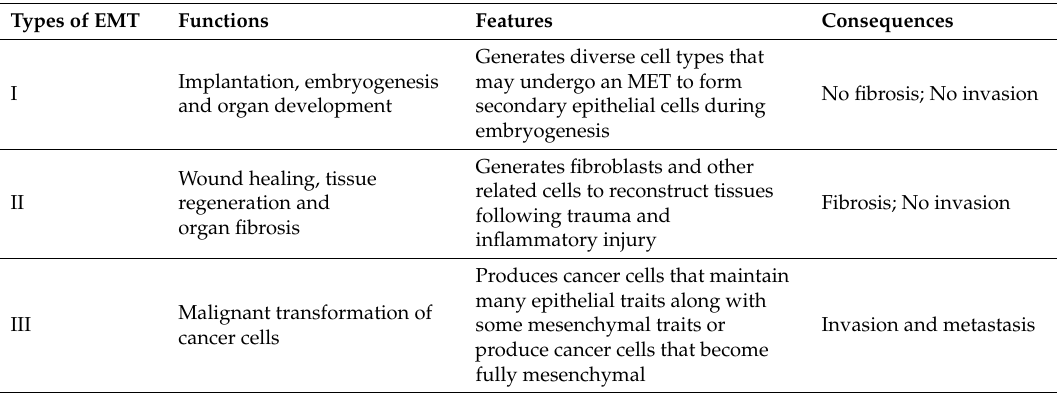
Table 1. Three types of the epithelial mesenchymal